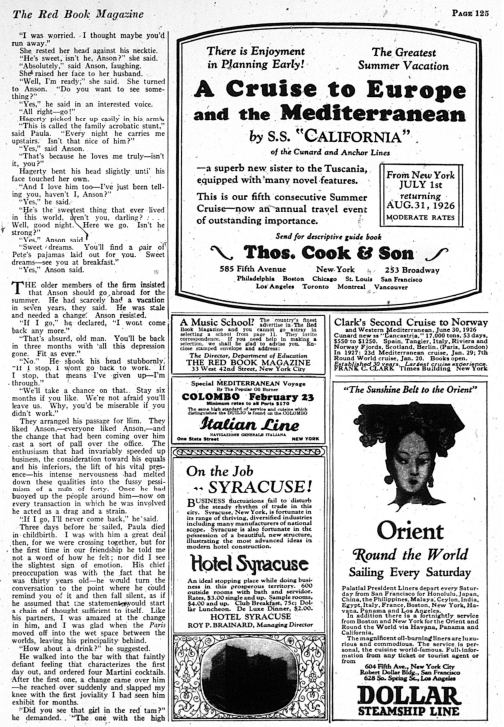
Figure 5. “The Rich Boy” as it first appeared in the February 1926 issue of Red Book Magazine (Fitzgerald 1926b), p. 125.